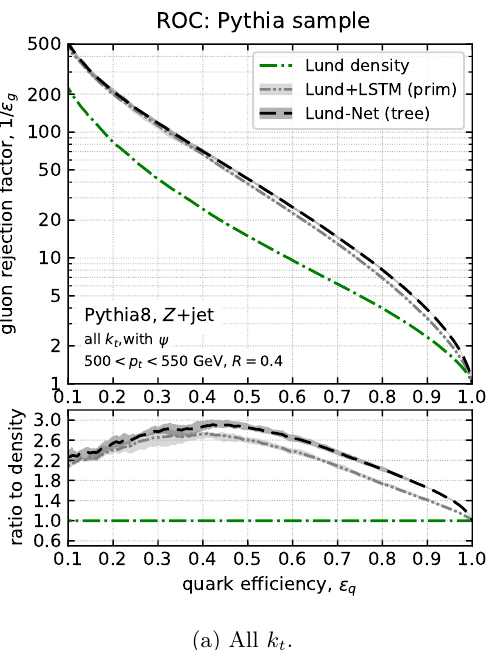
cut of 1 GeV has been applied. t